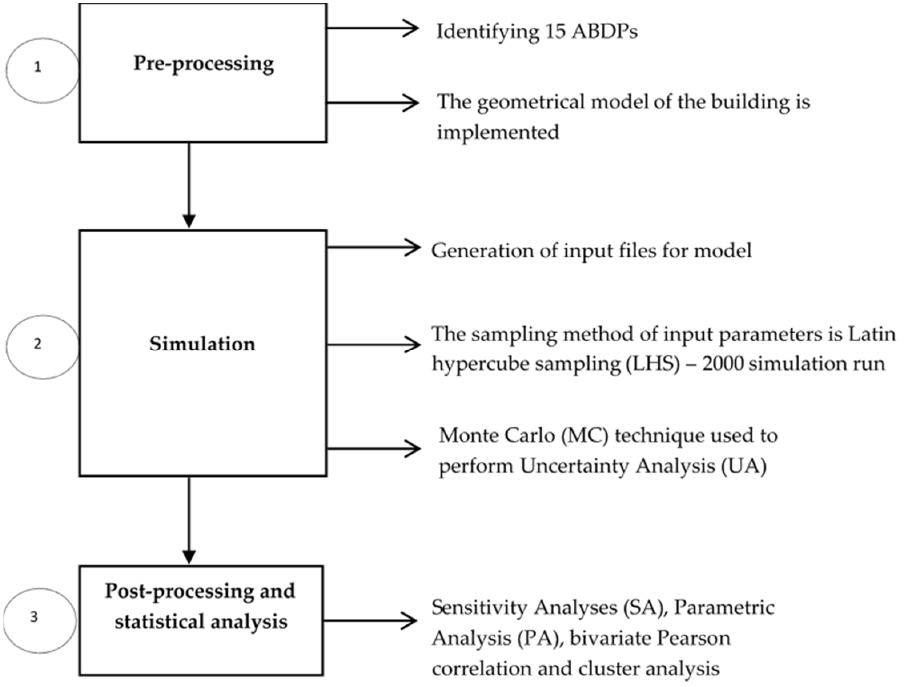
Figure 1. Illustration of the methodology for processing the MC technique and statistical analysis by using the BES tool and SPSS software.